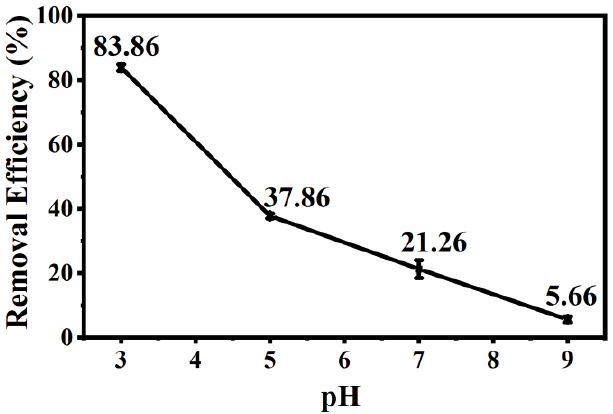
Figure 5. Effect of pH on the removal of Cr(VI) in solution: pH = 3–9; T = 13 h; m = 0.01 g; V = 15 mL; C 0 = 100 mg L − 1 .